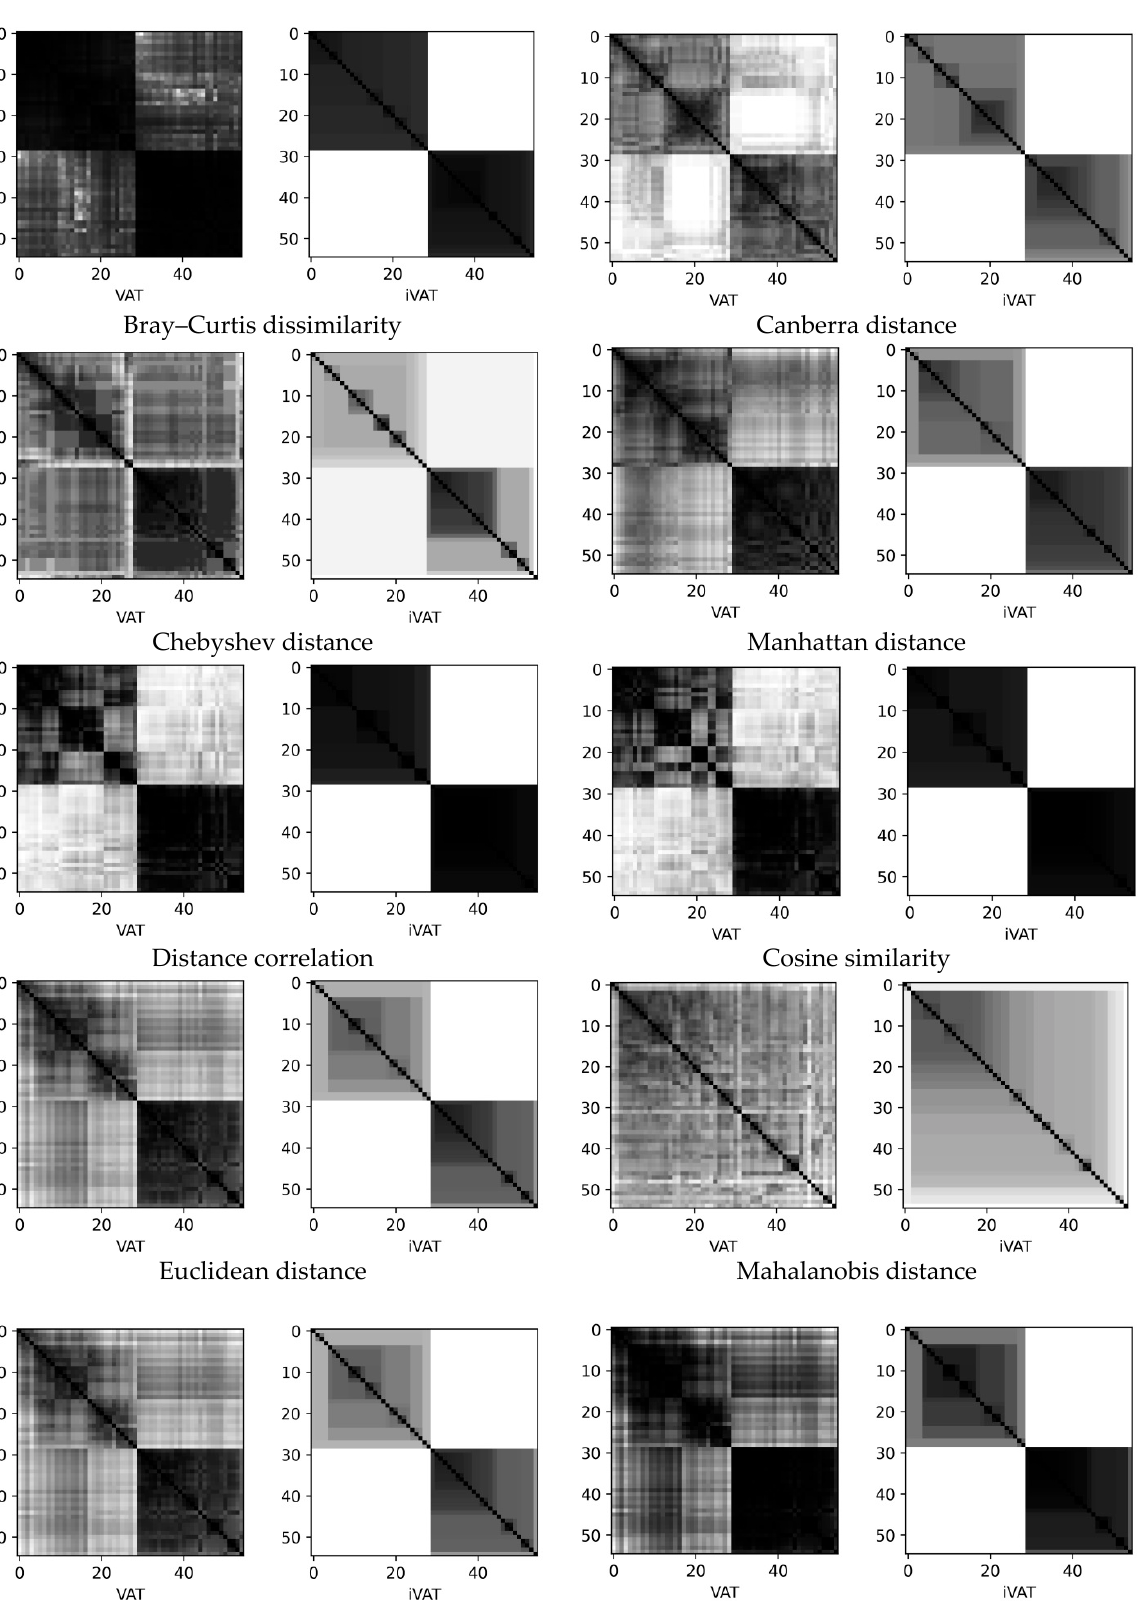
Figure A4. 140UD25AS1VK. Cluster heat map.